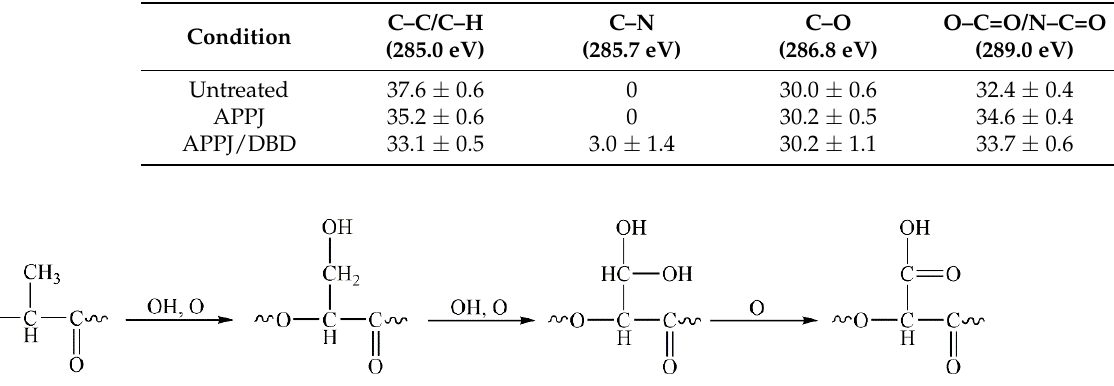
Figure 8. Proposed mechanism for the APPJ treatment of PLA solutions in argon plasma.